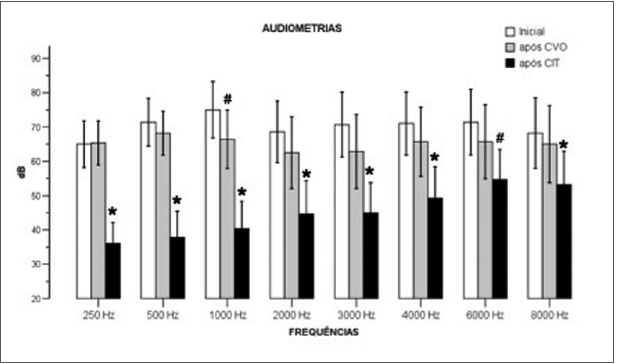
Figura 4. Comparação entre Recuperação e Modalidades Terapêuticas.